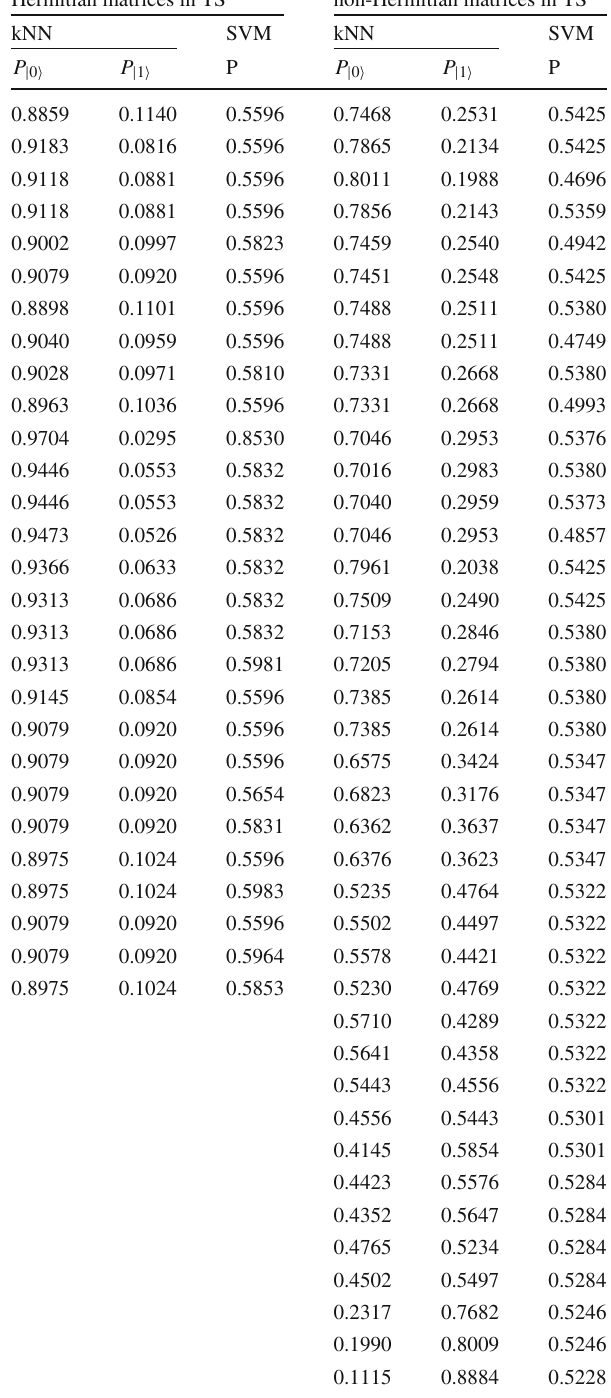
Table 3 Results of pattern recognition for quantum versions of kNN and SVM methods Hermitian matrices in